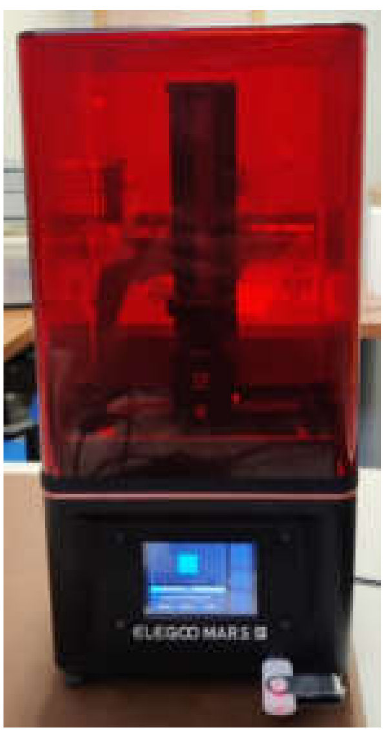
Figure 1. Photograph of the printer